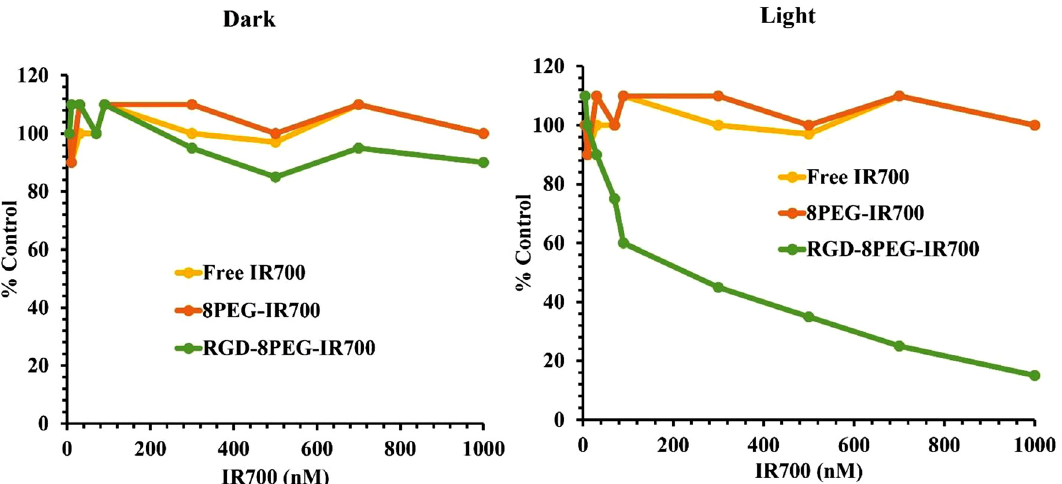
Figure 13: Determination of the dose-dependent (A) cytotoxicity and (B) phototoxicity of free IR700, 8PEG-IR700, and RGD-8PEG-IR700 in A375 cells. Light irradiation at 660 nm with 3.5 mW cm − 2 for 30 min fl uent rate. Adapted from Zhao et al. [40].